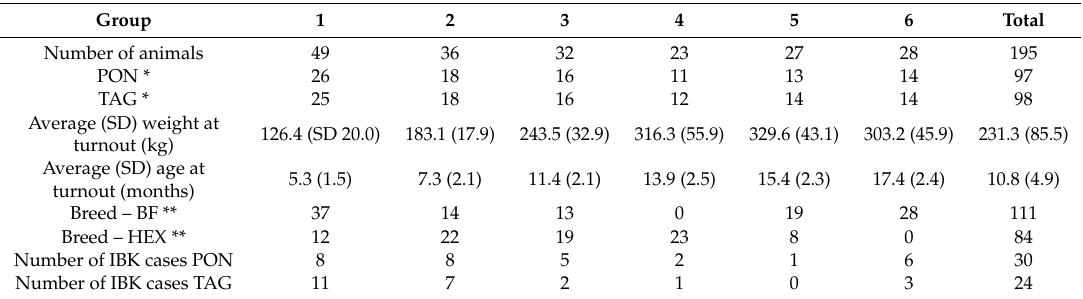
Table 1. Overall numbers of animals and infectious bovine keratoconjunctivitis (IBK) cases in six di ff erent management groups.